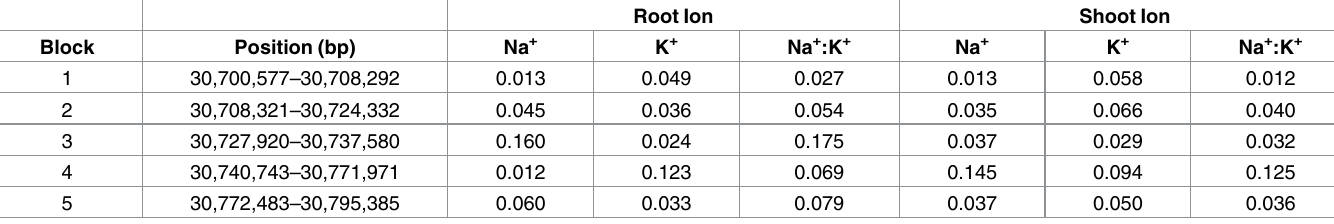
Table 2. Proportion of variation explained by a subset of the haplotype blocks within RNC4